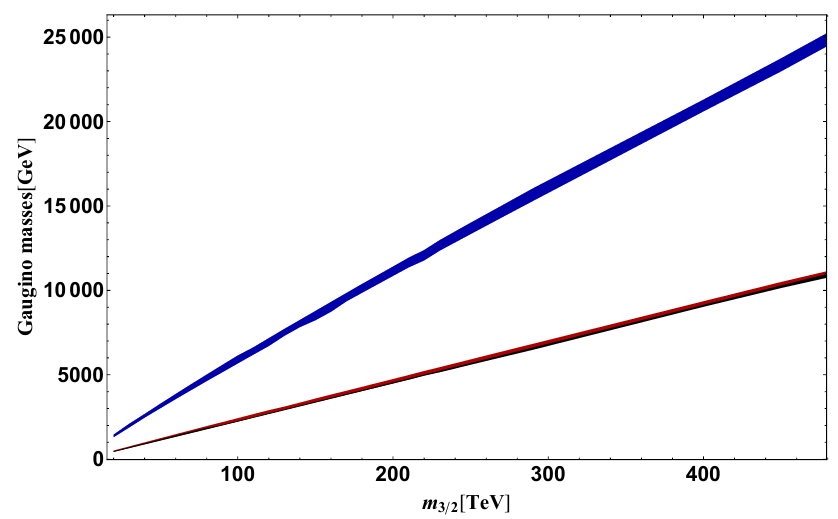
Figure 4 . The masses of gluino (blue band), lightest chargino (red band) and lightest neutralino (black band) from top to bottom. We vary 40 (cid:20) tan (cid:12) (cid:20) 80 ; 0 : 01 (cid:20) c h (cid:20) 3 and (cid:0) 2 : 7 (cid:20) c u = c d (cid:20) (cid:0) 1 : 3 with sign[ (cid:22) ] = (cid:0) 1 (cid:12)xed. Only data points with the (meta)stable electroweak vacuum and neutralino LSP are